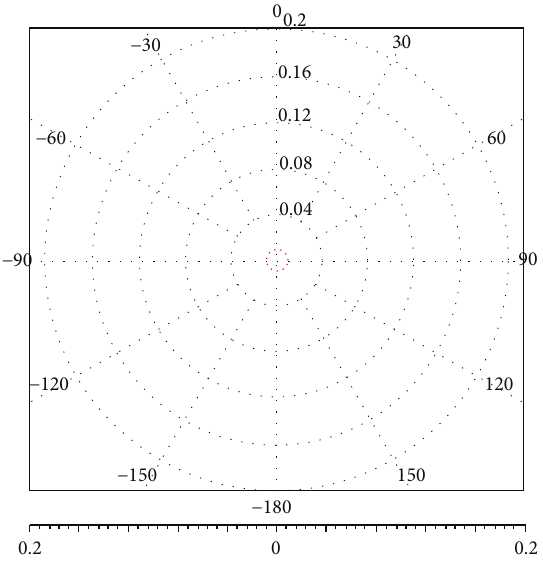
F 15: Antenna efficiency when the gap between electrodes